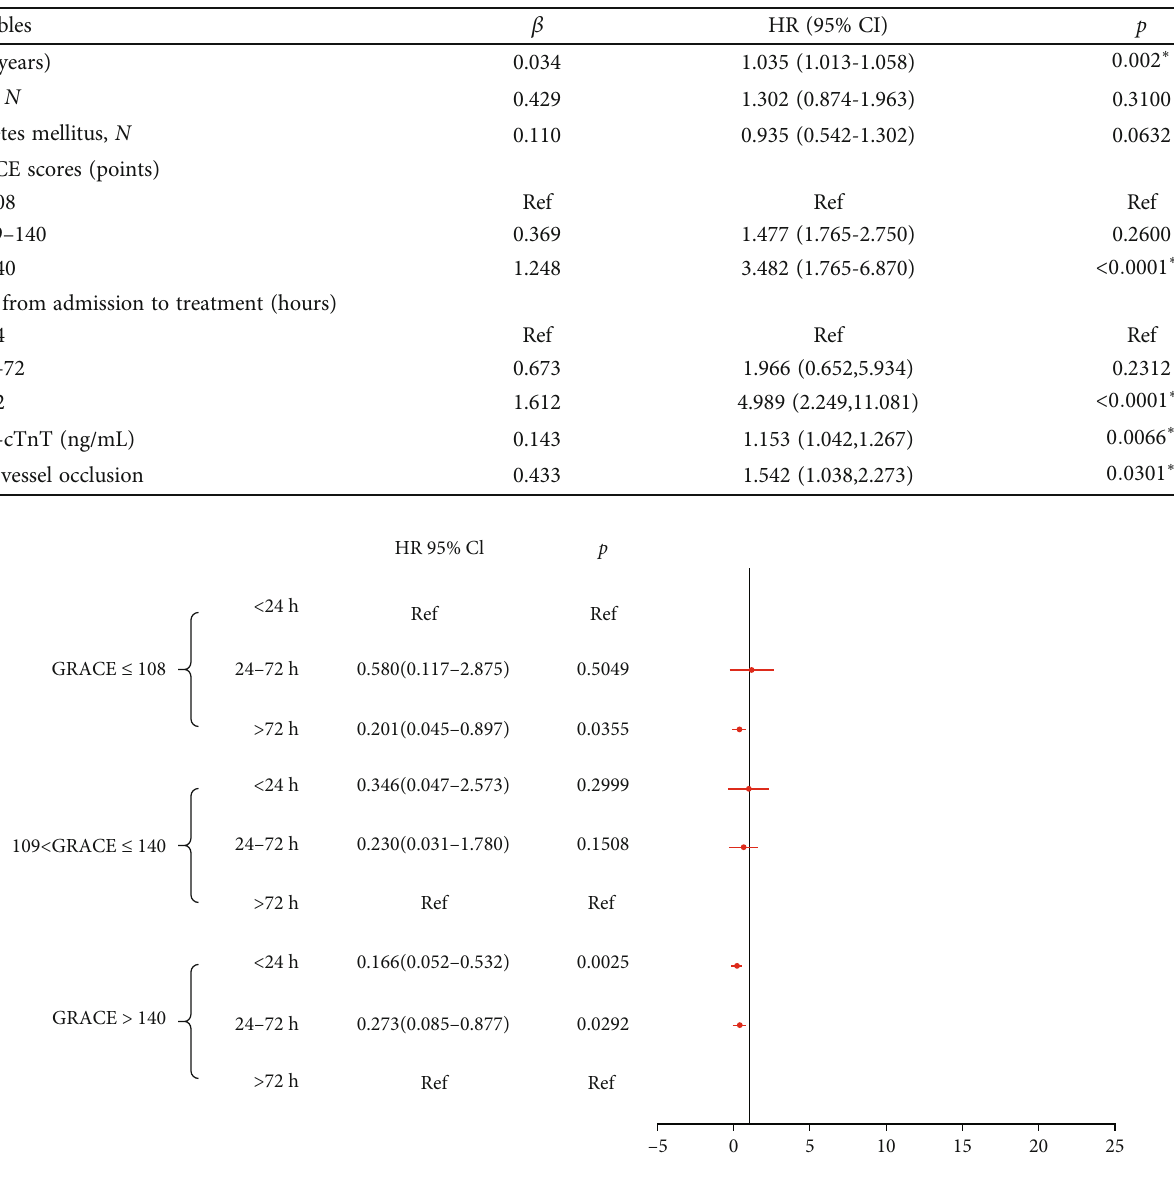
Figure 2: Forest chart of the subgroup analysis of the impact of the GRACE score and intervention time on MACE events.